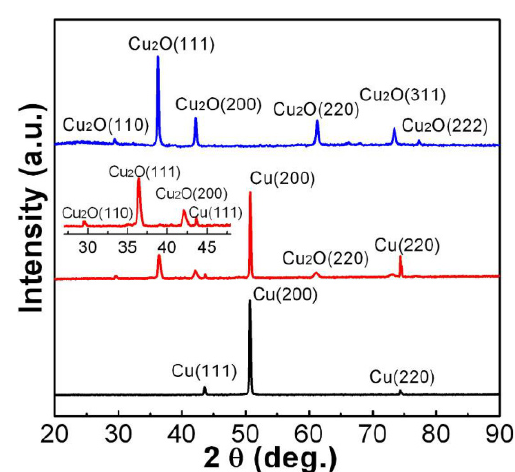
Figure 2. XRD patterns of Cu foil before (the bottom black one) and after heat treatment (the middle red one). The top blue one is the XRD pattern of the surface oxidation layer after heat